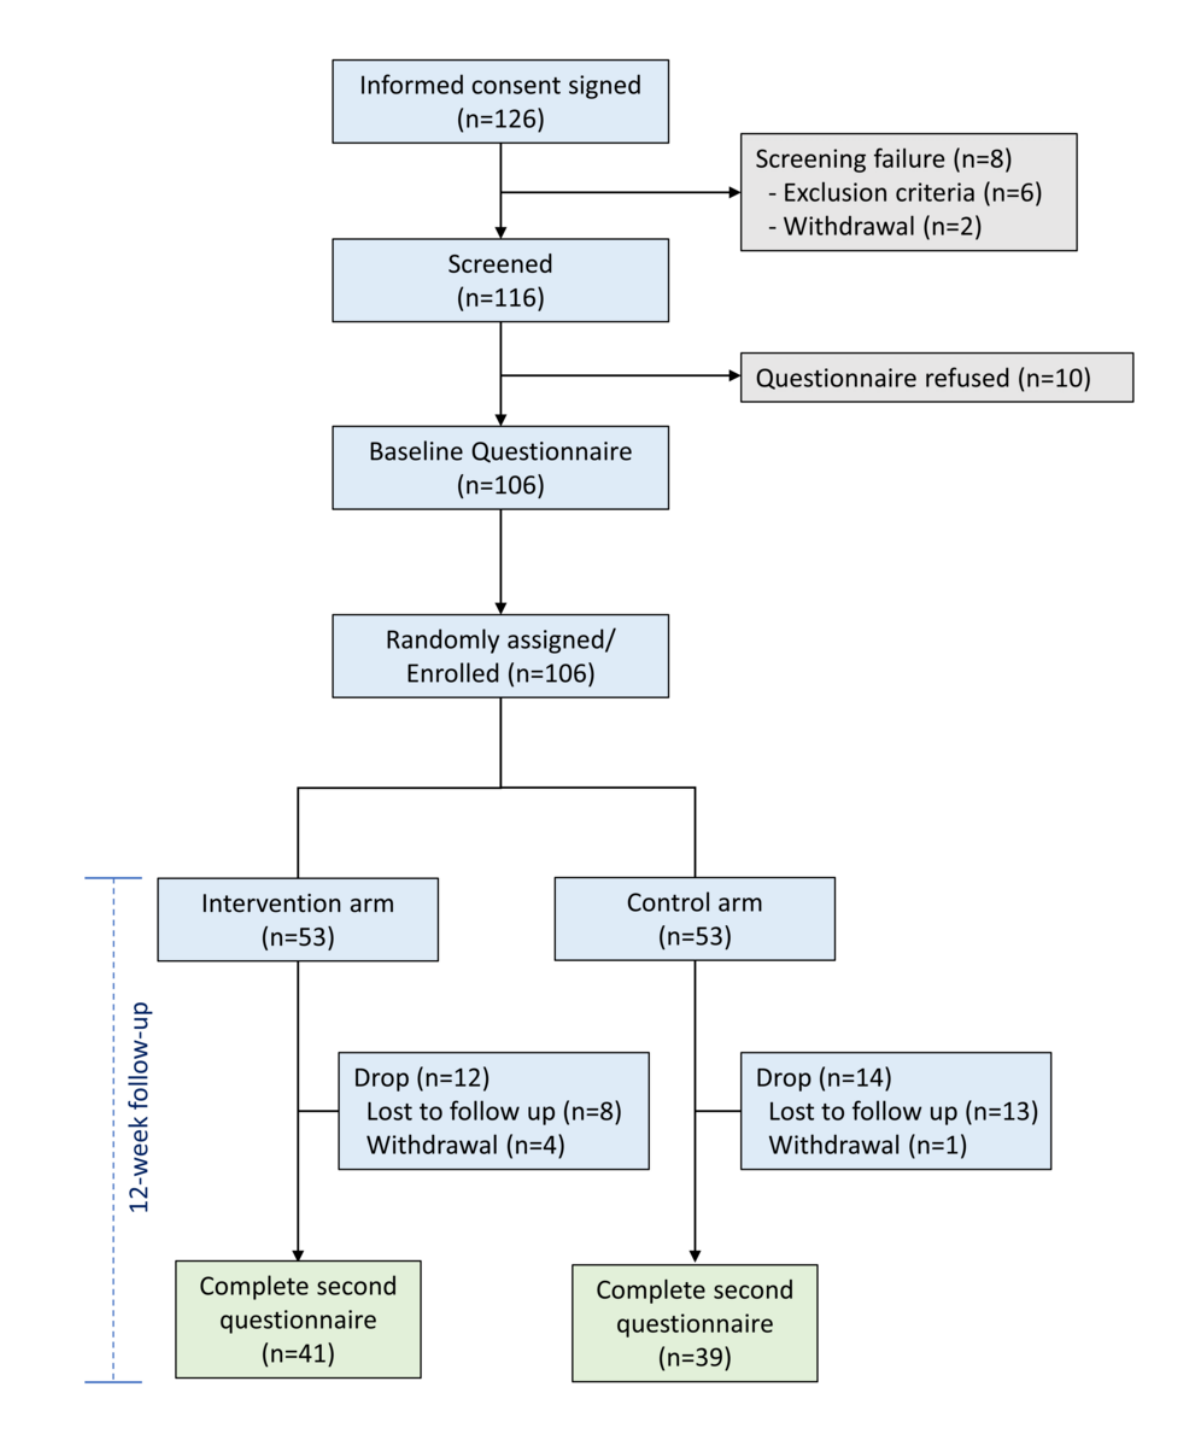
Figure 1. Flowchart depicting the study